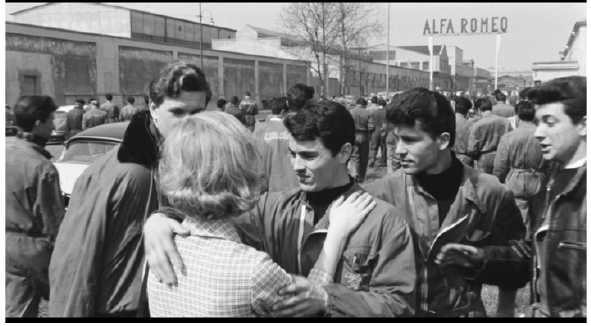
Figure 2 Screenshot from Rocco and His Brothers. (Goffredo